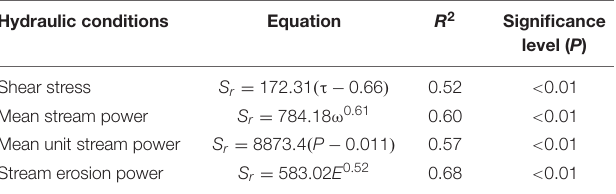
TABLE 3 | Relationships between soil loss rate and hydraulic conditions. Hydraulic